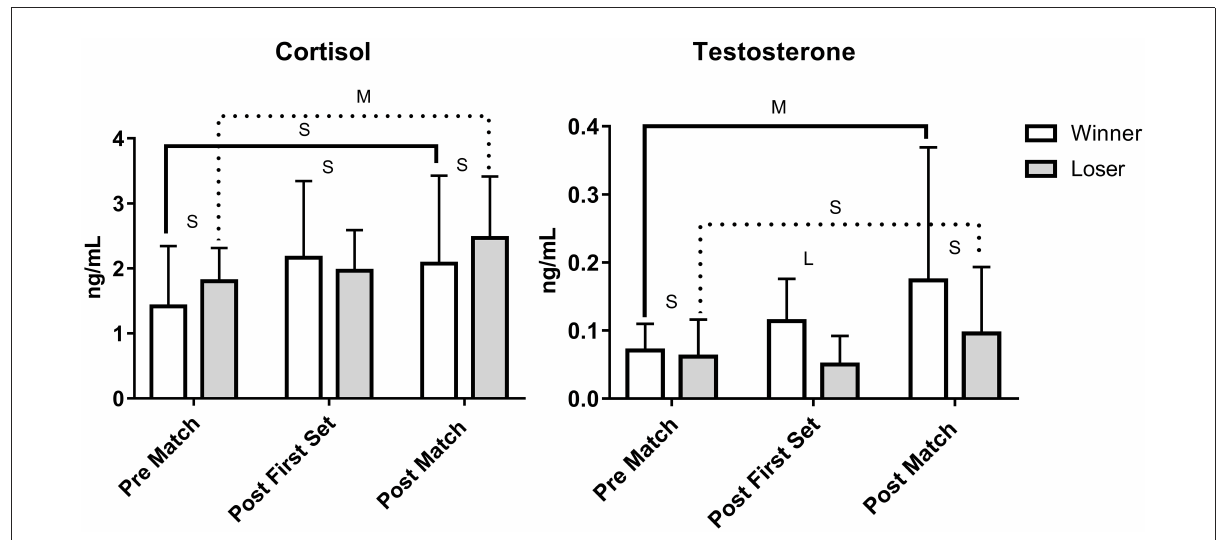
FIGURE1 Effect size of match on cortisol and testosterone in winners and losers of a beach volleyball match. S, small effect size; M, moderate effect size; L, large effect